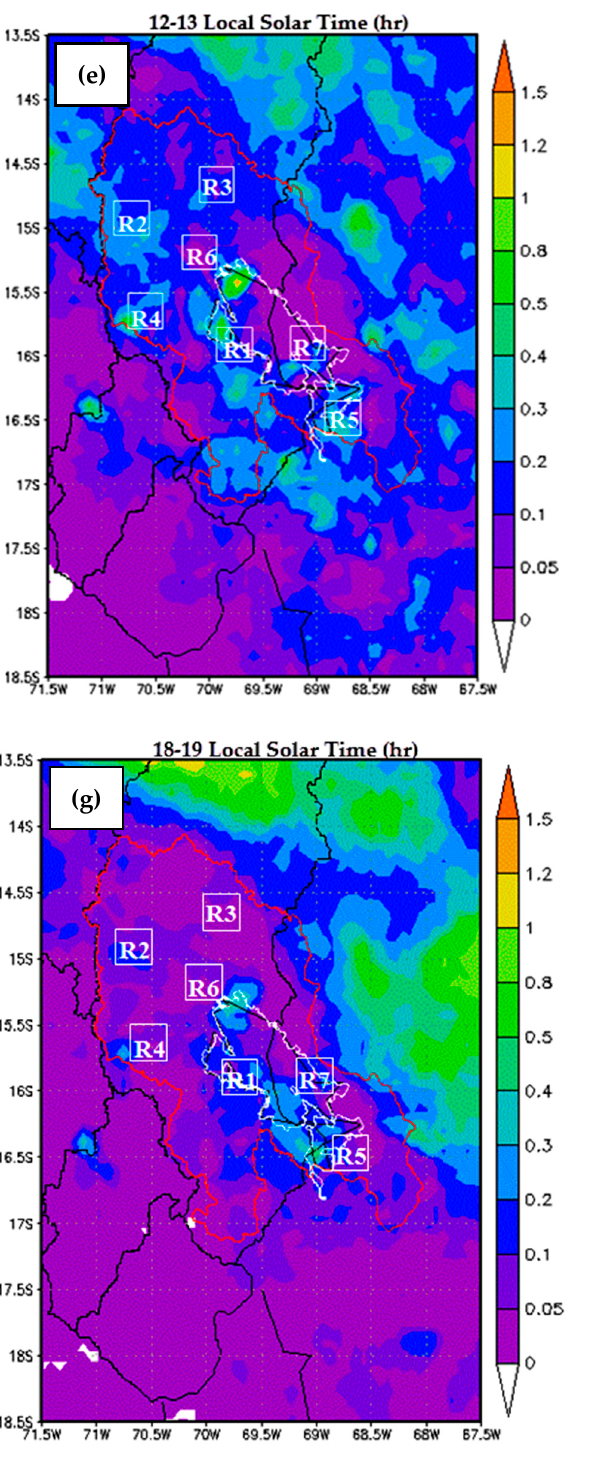
Figure 8. Spatial distribution of the average rainfall accumulation field obtained from the CMORPH data, period 2002–2013. Color scale represents precipitation in millimeters (mm/hr). The diurnal cycle of precipitation is represented in local solar time (LST). Vertical axis indicates the latitudes, and the horizontal axis refers to the lengths, both in degrees ( ◦ ). The white boxes (R1–R7) are the regions selected for the analysis. ( a ) 0–1 Local Solar Time; ( b ) 3–4 Local Solar Time; ( c ) 6–7 Local Solar Time; ( d ) 9–10 Local Solar Time; ( e ) 12–13 Local Solar Time; ( f ) 15–16 Local Solar Time; ( g ) 18–19 Local Solar Time; ( h ) 21–22 Local Solar Time.